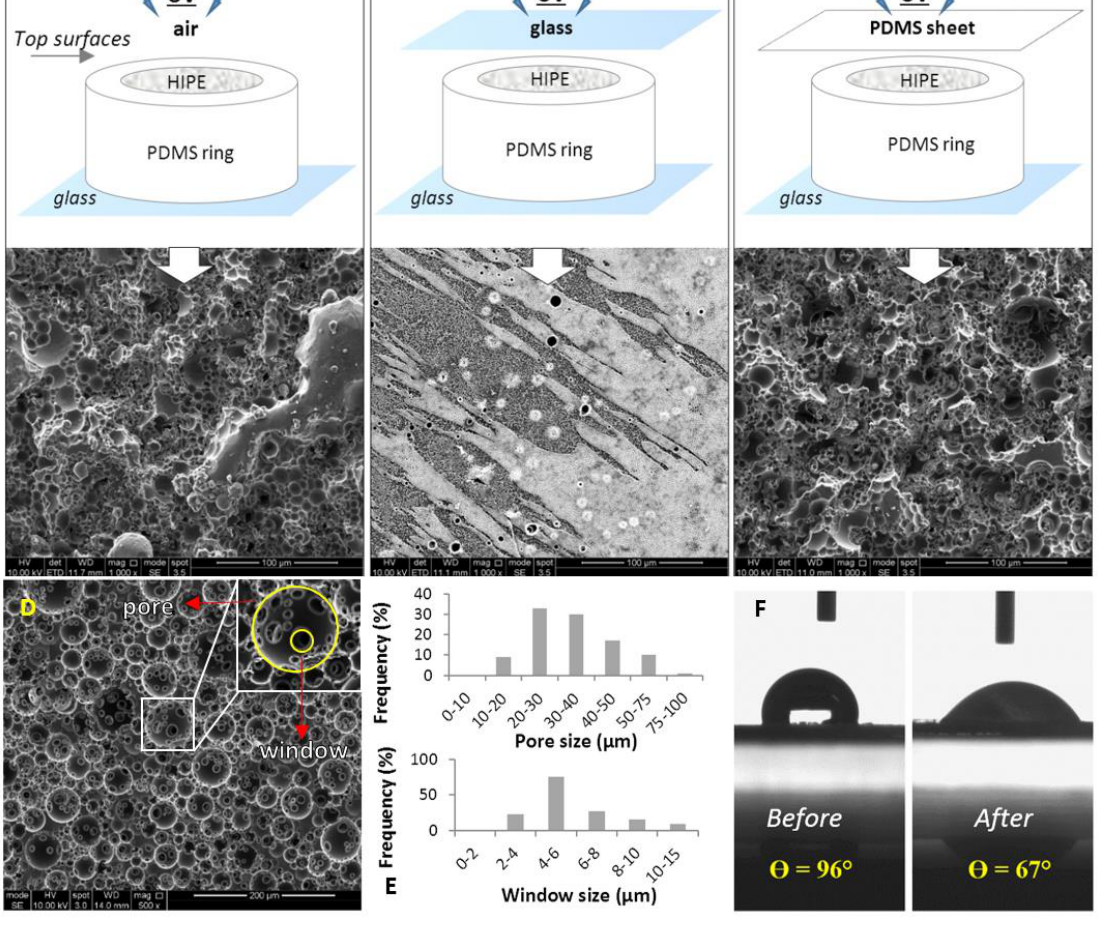
Figure 2. Scanning electron microscope (SEM) images of the top surfaces PCL polyHIPEs cured in contact with; ( A ) air, ( B ) glass, and ( C ) polydimethylsiloxane (PDMS) sheet. ( D ) SEM image of the transverse section of PCL polyHIPEs. ( E ) Pore size and window size distributions of the inner section. ( F ) Contact angle measurements of a water droplet on PCL polyHIPE before and after air plasma treatment (n = 3).